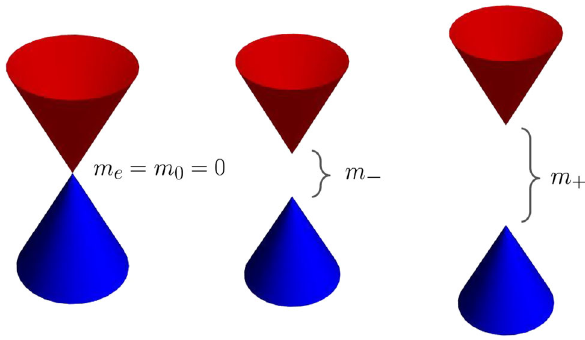
Fig. 3 Sketch of masses for the fermion fields in Lagrangian (6). One specie becomes heavier and the other one lighter as m 0 grows